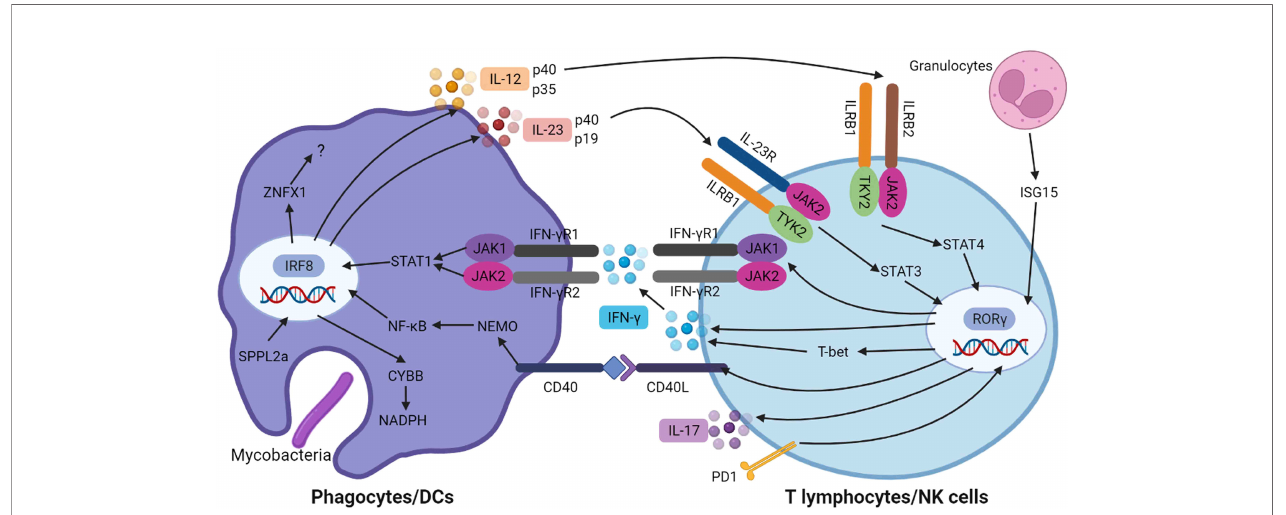
FIGURE 1 | Genetic spectrum and immunological mechanisms of MSMD. When mycobacteria infection is initiated, the pathogen-associated molecular patterns are recognized via various phagocyte-expressed pattern-recognition receptors to facilitate phagocytic uptake of the bacteria and result in the production of IL-12 and IL- 23, which bind to their receptors (ILRB1/ILRB2/IL-23R) on effector T cells leading to activation of TYK2/JAK2 signaling, consequent to STAT4 and STAT3 phosphorylation and dimerization, respectively. CYBB is required to the assembly of NADPH oxidase complex. These signaling pathways induced the transcription of IFN- g and IL-17, which are mediated by ROR g . The IFN- g is secreted and binds to its receptor on phagocytes, resulting in the activation of JAK1/JAK2 and STAT1 phosphorylation and dimerization, which then translocate to nucleus, resulting in the transcription of host defense genes. Meanwhile, the interaction of CD40 and its ligand result in the activation of NEMO and NF- k B mediated in fl ammation. This fi gure was created with